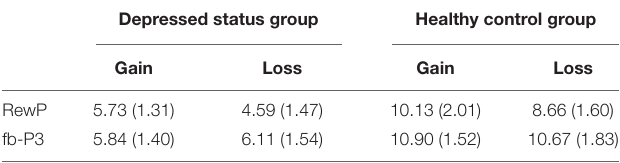
TABLE 2 | The mean amplitudes ( µ V) of the ERP components (M ±